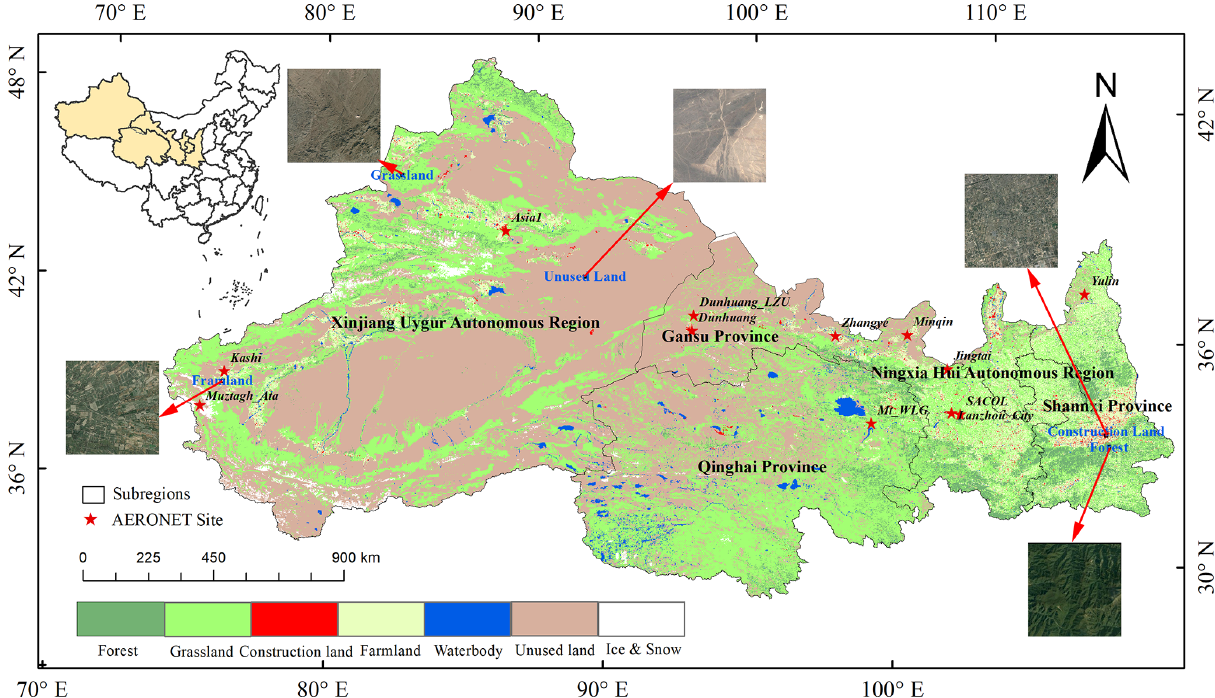
Figure 1. Study area. The figure shows the typical arid and semi-arid areas and AERONET site distributions; five provinces/autonomous regions in northwest China. The five ecological zones were derived from © Google Earth (https://earth.google.com/, last access: 28 Septem- ber